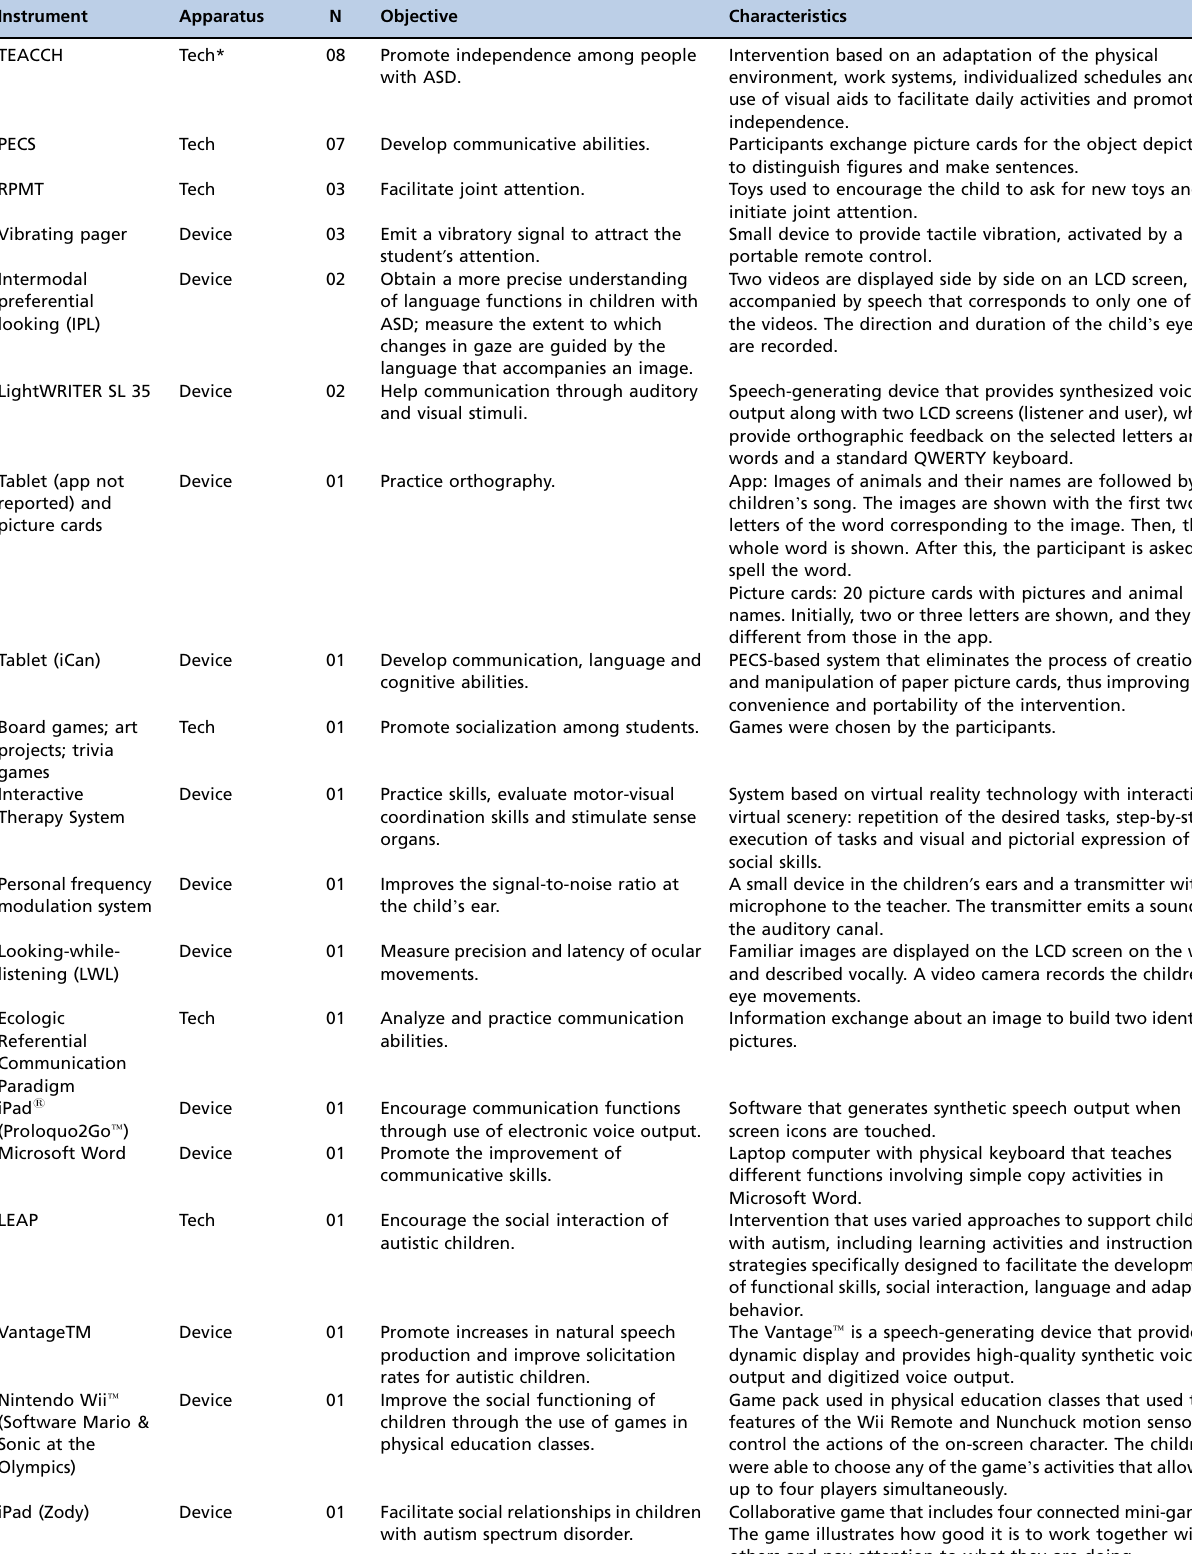
Table 3 - Objectives and characteristics of the instruments used, ordered by frequency of